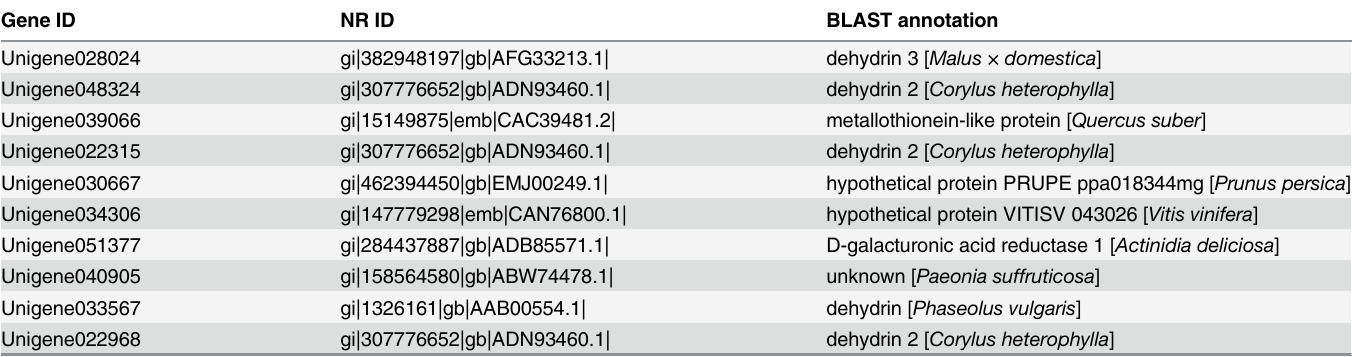
Table 5. The ten most highly expressed transcripts in ‘ Hangbaishao ’ transcriptome libraries. Gene ID